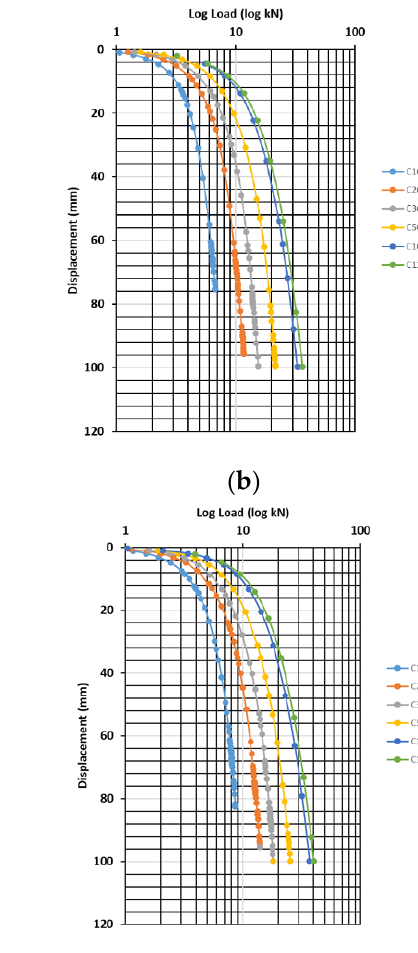
Figure 7. Elasticity modulus versus ultimate load for CHSB 1 pile.